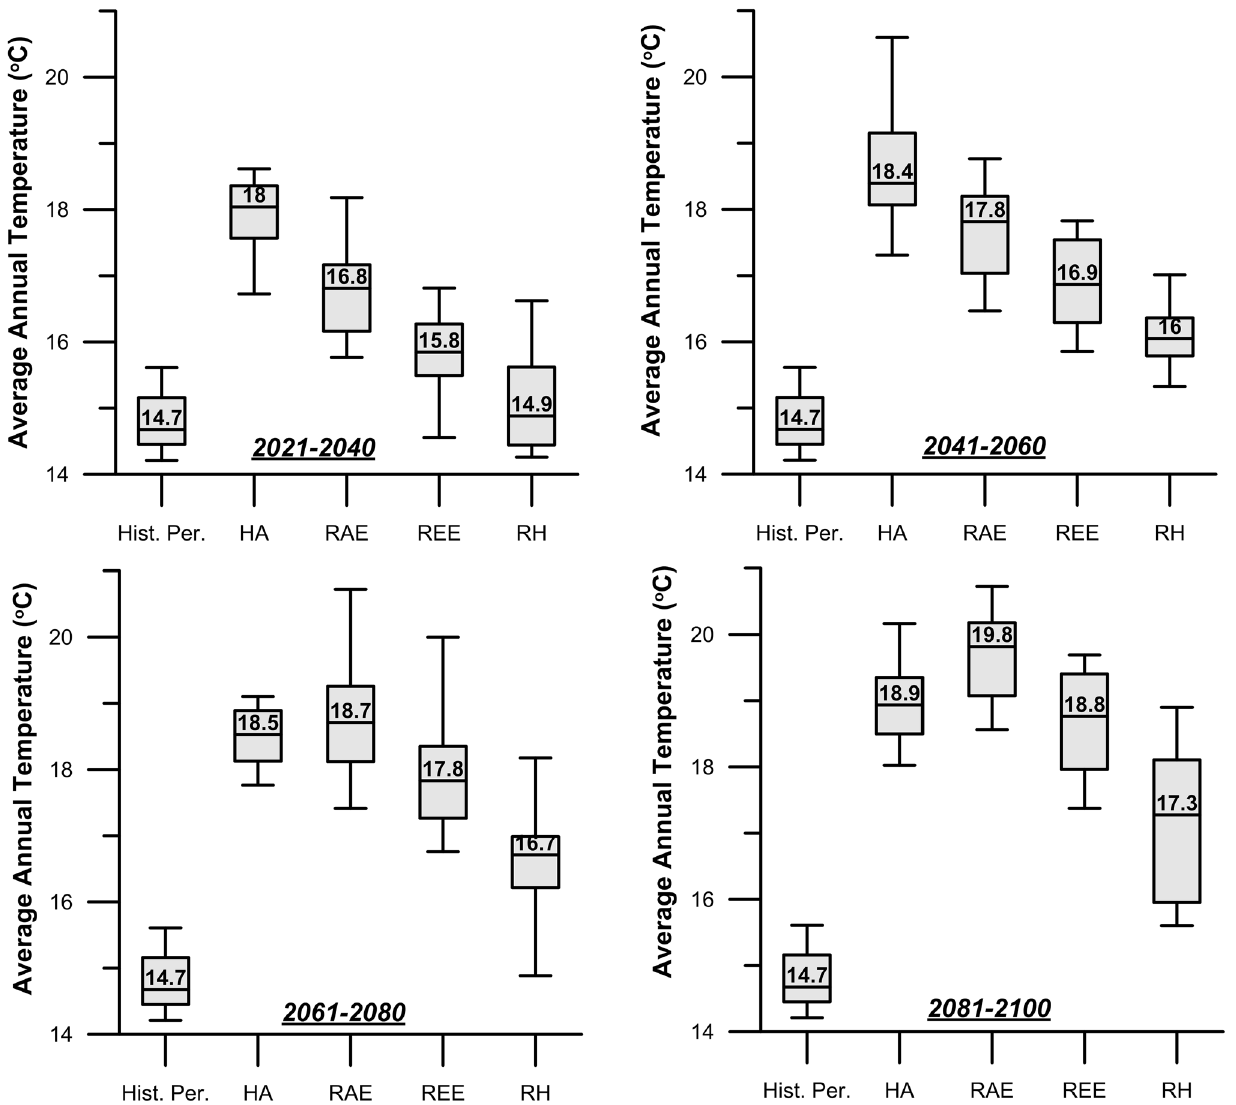
Fig. 8 Box-plots of average annual temperature variation according to results from the four RCM–GCM combinations for the periods